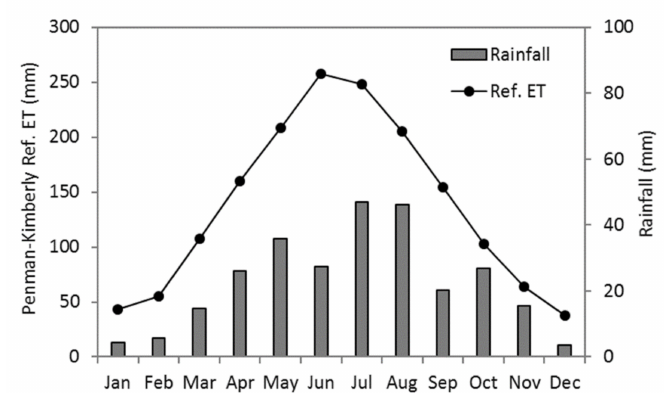
Figure 3. Monthly average rainfall and reference evaporation in the study